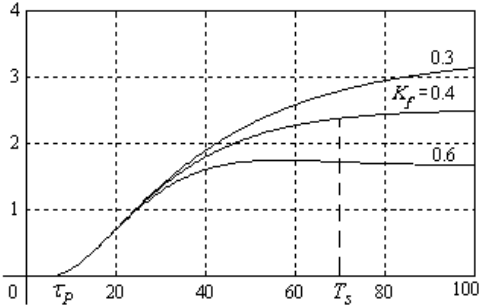
Figure 27. Compensated process responses to a unit step